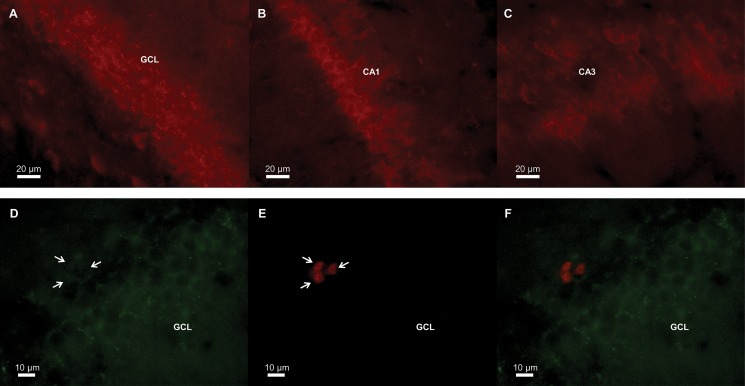
Photomicrographs of representative GPER expressing cells in the granule cell layer of the dentate gyrus (A), and the CA1 (B) and CA3 (C) regions of the hippocampus.GPER (green) is expressed in the granule cells (D) but not in proliferating (E) cells (red; arrows indicate Ki67-expressing cells), in the granule cell layer (GCL) of the dentate gyrus (F, merged figure).